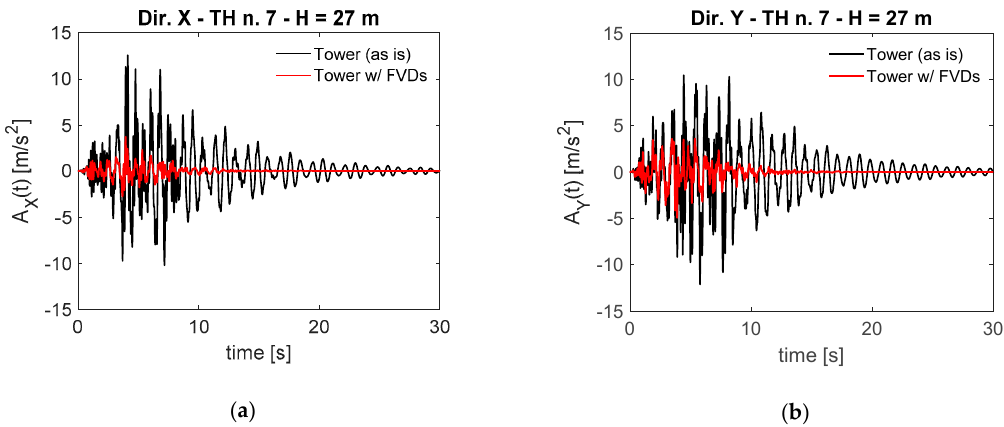
Figure 21. Maximum absolute acceleration time series for the nonlinear dynamic case of analysis TH n. 7. Response comparison before and after retrofitting: ( a ) X direction; and ( b ) Y direction.